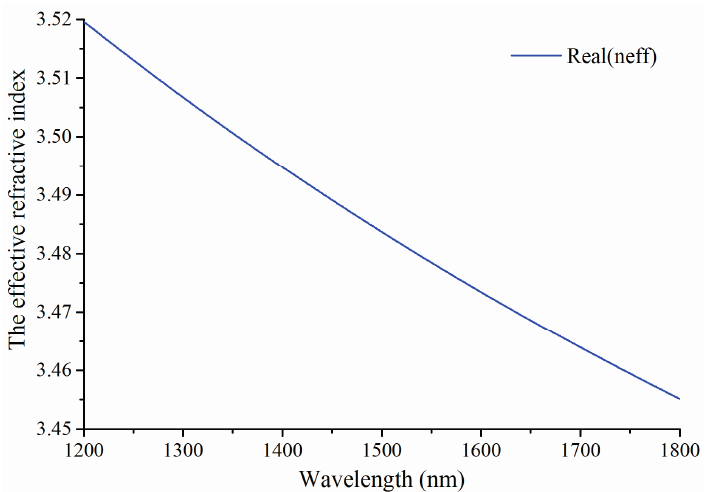
Figure 4. The dispersion of the fundamental transverse electric (TE) guiding mode of the SOI rib waveguide with the total rib height of 10 μ m, outside rib height of 5 μ m, rib width of 5 μ